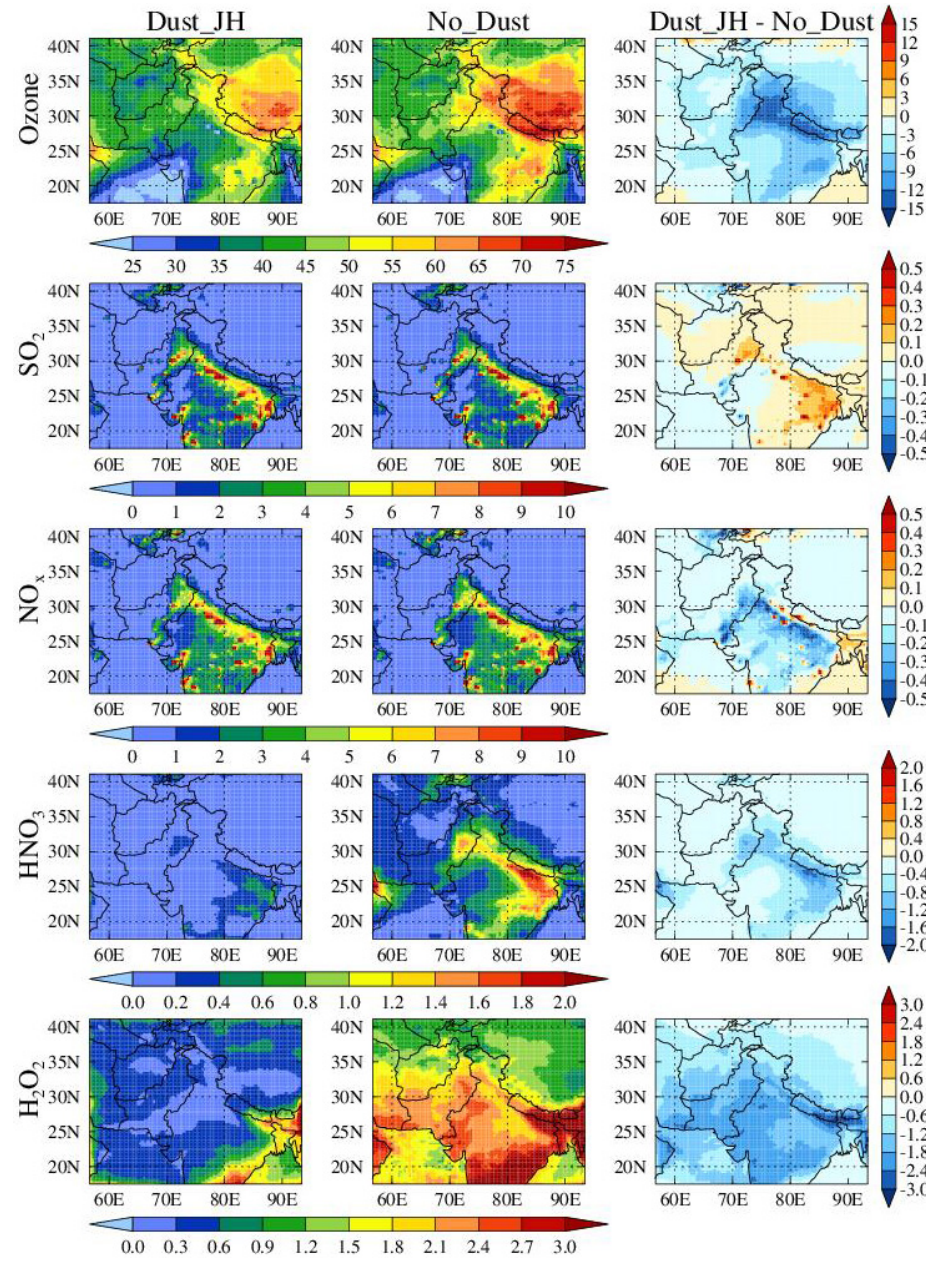
Figure 5. Spatial distributions of average surface O 3 , SO 2 , NO x , HNO 3 and H 2 O 2 mixing ratios simulated by WRF-Chem with Dust_JH and No_Dust configuration during 17–22 April 2010. The absolute difference between the two configurations is also shown. All values are